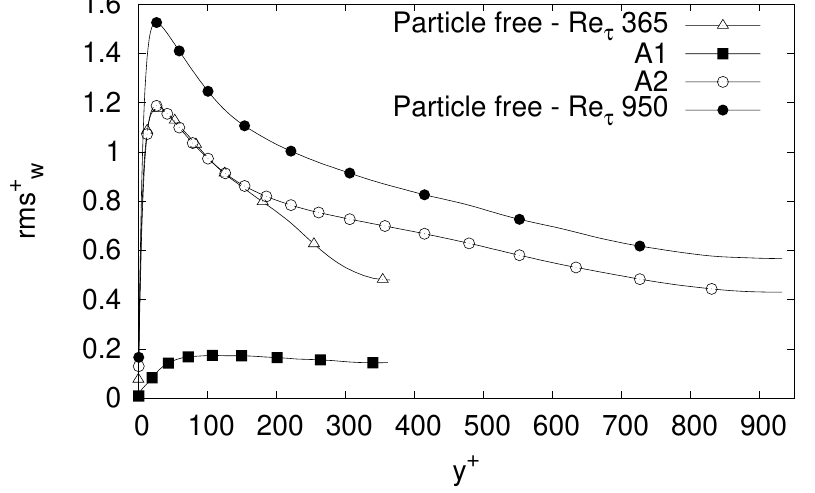
Figure 14. rms + w - Profiles for A1, A2 and particles free cases. ( A 1 : u τ = 0.073; A2: u τ =